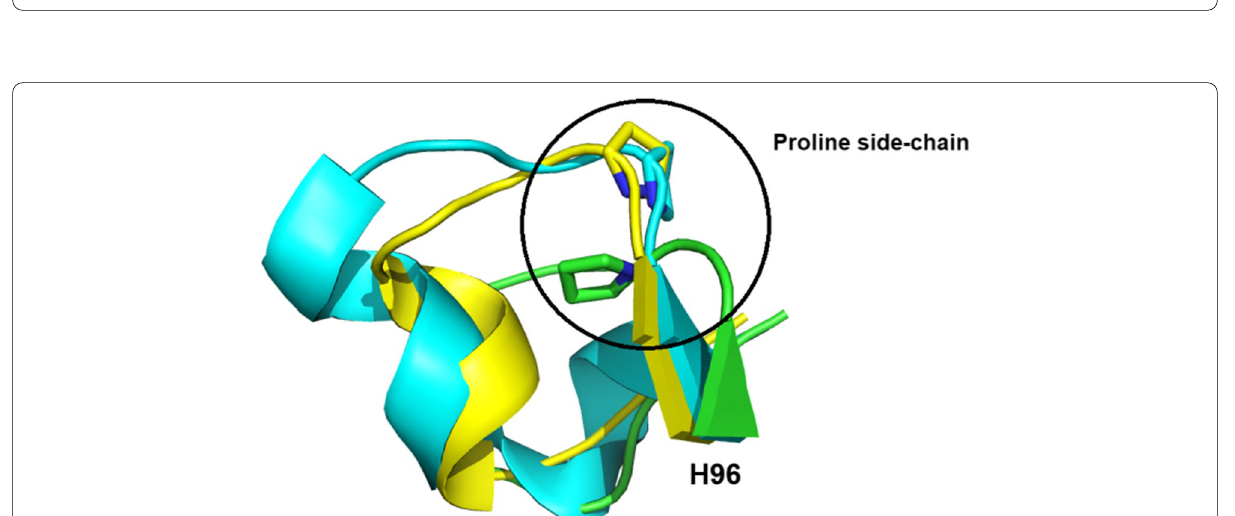
Fig. 8 CDR3 loops from three superimposed Nbs (PDB ID: 3K7U, 6EY0, 6QGW). The proline side chain at H96 is shown as a